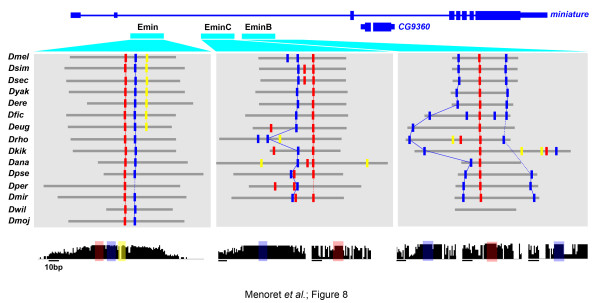
Pattern of evolutionary conservation of the three enhancers driving miniature expression in trichome cells. The position of epidermal enhancers is shown by cyan boxes and their respective architectures with respect to svbF7 (red), blue and yellow motifs are schematized across Drosophila species. Orthologous sequences were identified by BLAST and manually adjusted for optimized alignment. Motif search was performed in individual sequences taken independently, using the same threshold for each motif in all cases. Bottom histograms represent the pattern of evolutionary conservation across Drosophila species, focusing on individual regions harboring identified cis-regulatory motifs (color coded).